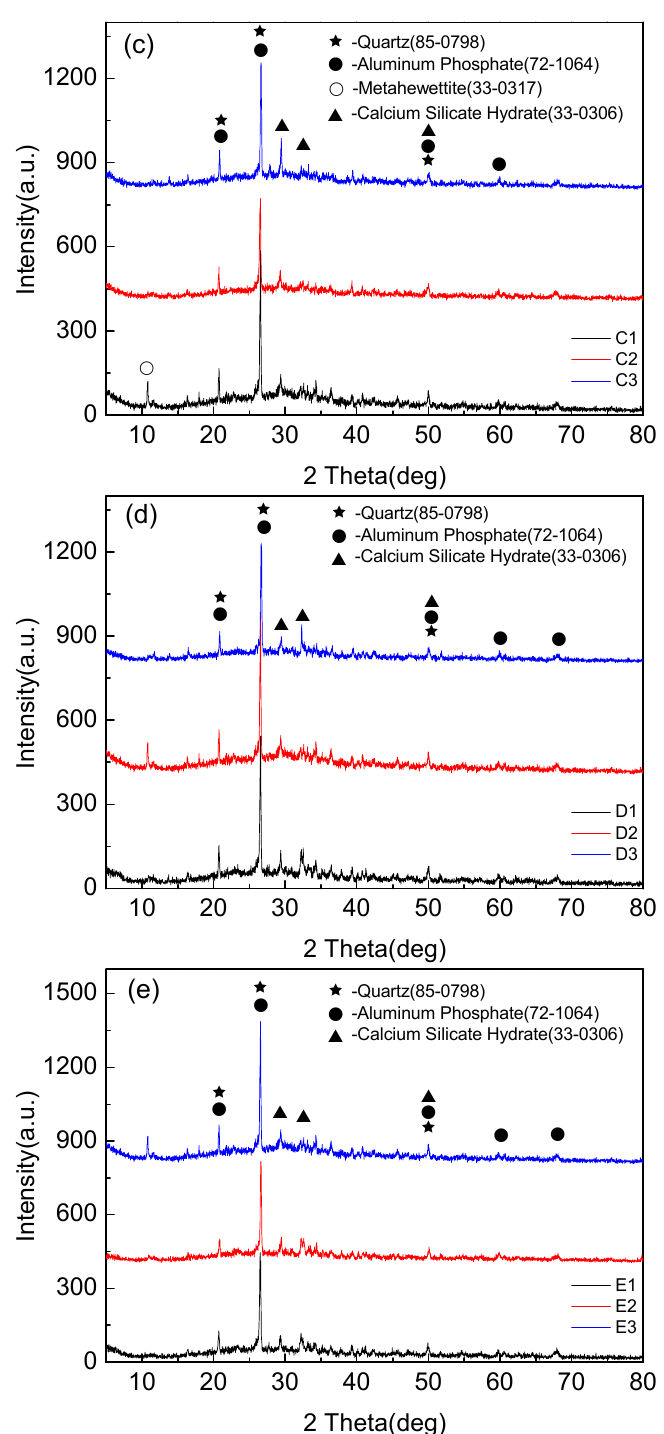
Figure 5. XRD di ff raction pattern of foamed geopolymer based on fly ash. ( a ) XRD patterns of samples A1, A2, A3, ( b ) XRD patterns of samples B1, B2, B3, ( c ) XRD patterns of samples C1, C2, C3, ( d ) XRD patterns of samples D1, D2, D3, and ( e ) XRD patterns of samples E1, E2,